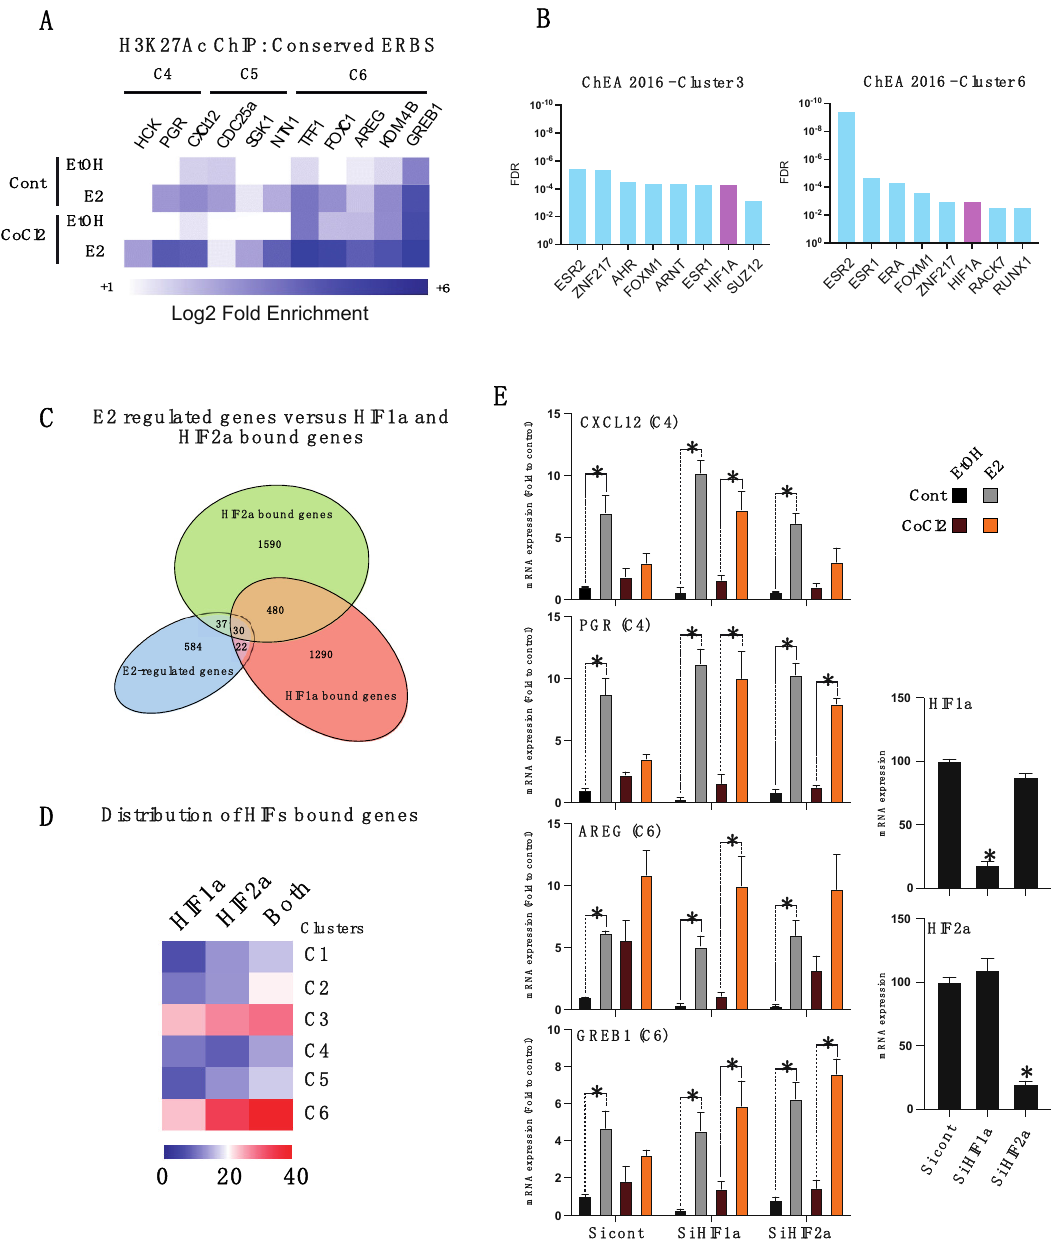
Figure 4. HIF1 α regulates a subset of ER α target genes and activates ER α -bound enhancers. ( A ) Heatmap of H3K27Ac targeted CHIP-qPCR experiments on enhancers located at the vicinity of genes belonging the clusters C4, C5 and C6. Data shown are the mean of relative enrichment of five independent experiments normalized to an internal control. ( B ) Analysis of transcription factor binding enrichment using ChEA algorithm on genes belonging to the clusters 3 and 6. ( C , D ) Venn diagram showing overlap between the 584 hormone-induced differentially expressed genes and the respective HIF1 α and HIF2 α bound genes in MCF7 as determined from (Mole et al., [33], using GREAT online tool and their respective distribution across the six different gene clusters. ( E ) Bar